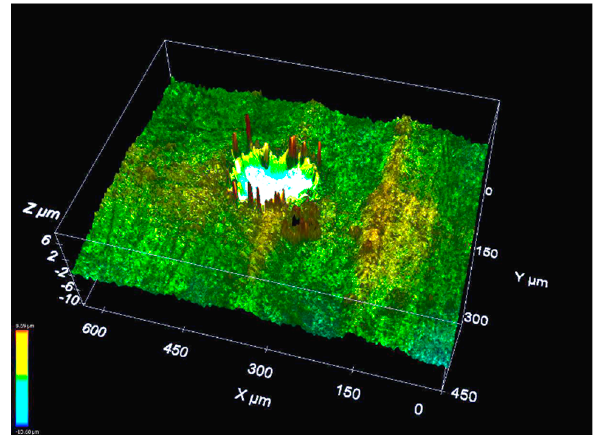
Figure 2. Rim generated by a single discharge on a ground surface (R a 0.46 μ m, R t 3.59 μ m). Rim height can be as much as 8 μ m.